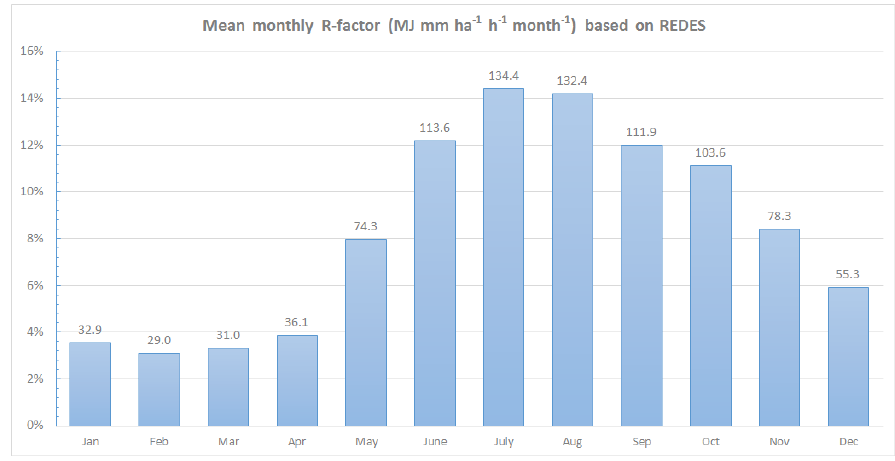
Figure 4. Monthly contribution (%) to the annual R-factor and mean monthly R-factor (top of columns in MJ mm ha − 1 h − 1 month − 1 ) of the REDES stations. The stations with an almost zero R-factor during winter months are located in Central and Eastern European countries (Czech Republic, Slovakia, Bulgaria, and Romania) and in the Northern ones (Sweden and Finland).